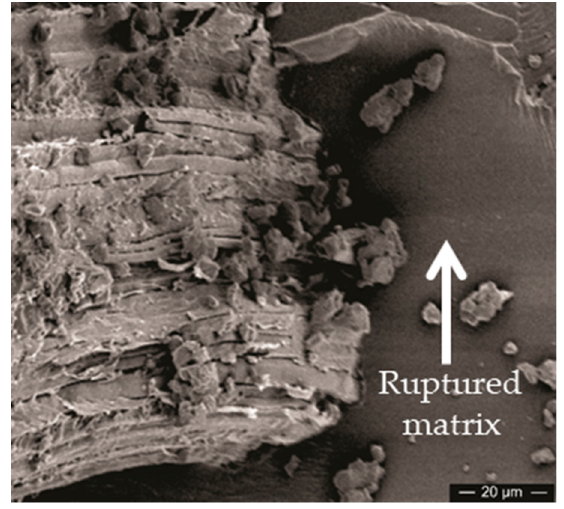
Figure 18 . Matrix rupture of the GOCF Composite. Figure 18. Matrix rupture of the GOCF